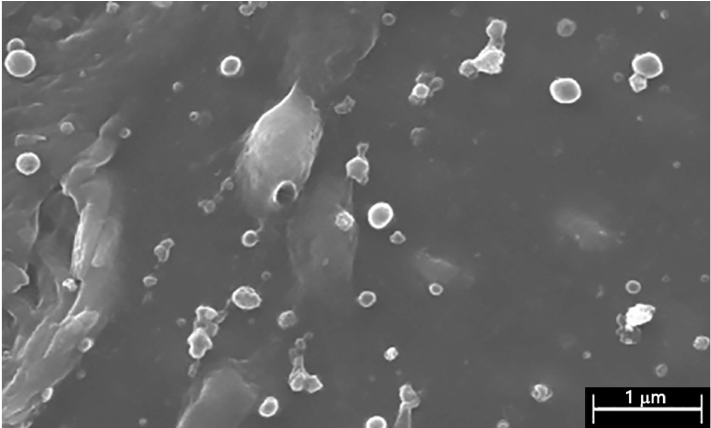
Figure 1. Scanning electron microscopy (SEM) micrograph of PLGA nanoparticles loaded with chlorhexidine, randomly distributed in a chitosan film (scale: 2 µm). The nanoparticles’ size ranges from 300 to 400 nm. Similar observations were recorded for the rifampicin-loaded polymer.